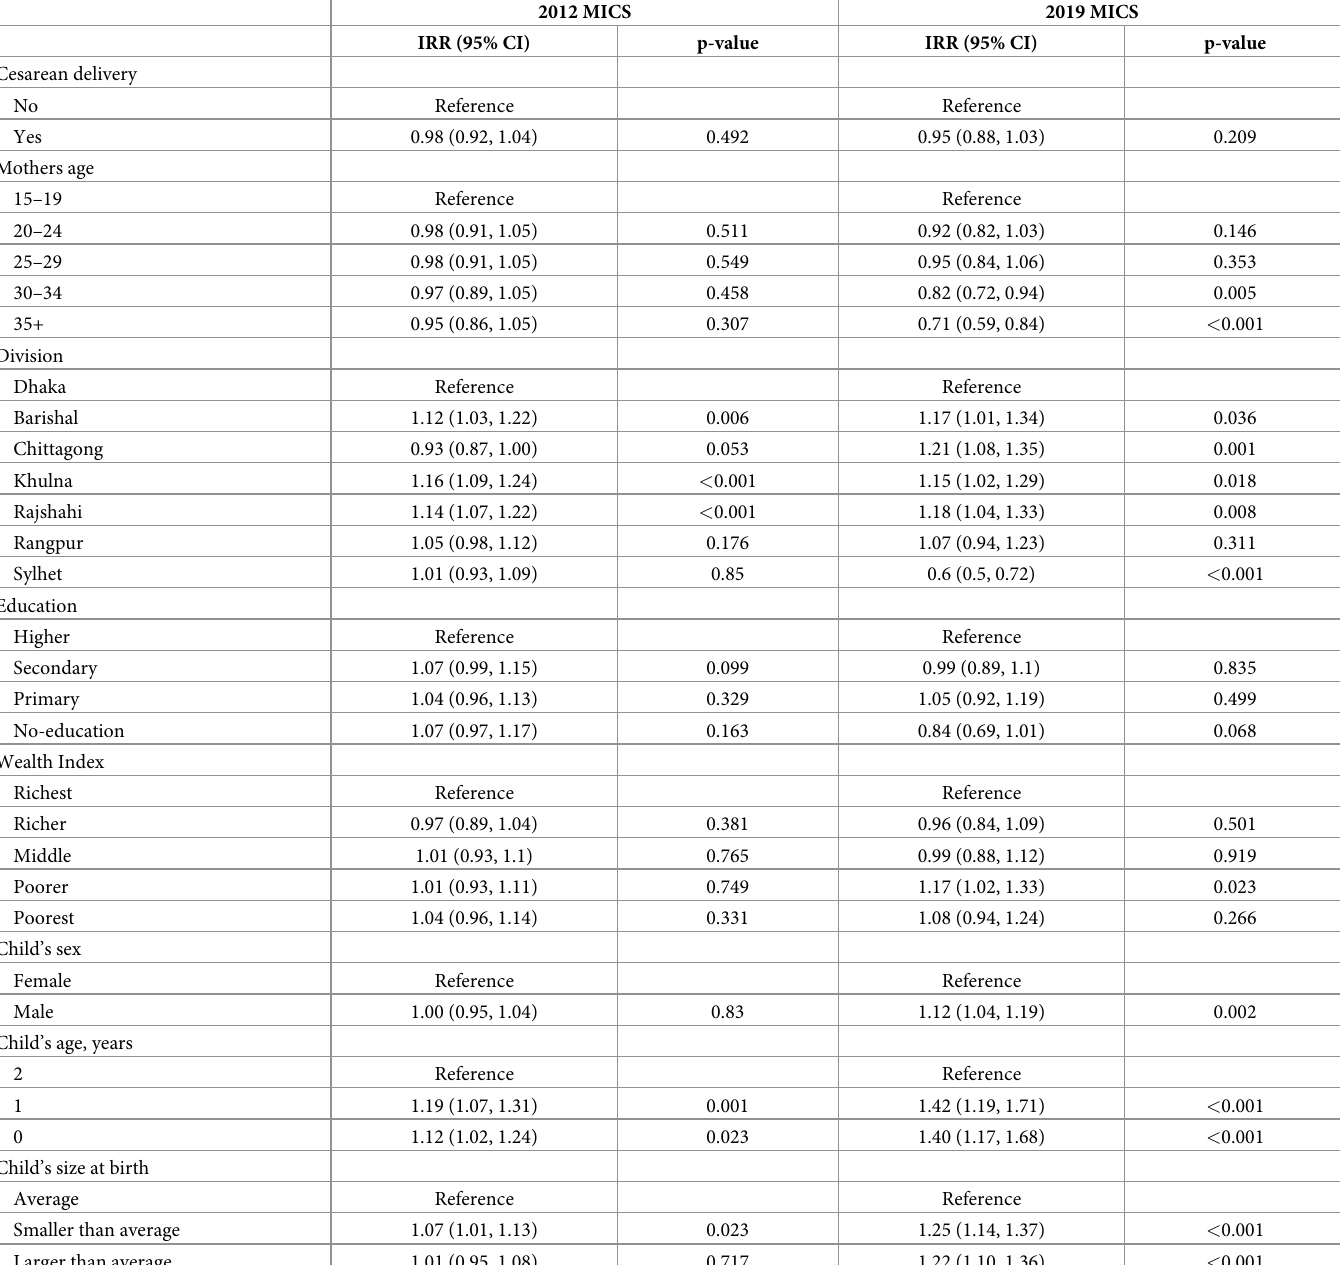
Table 4. Factors associated with cesarean vs normal delivery and common childhood diseases, MICS